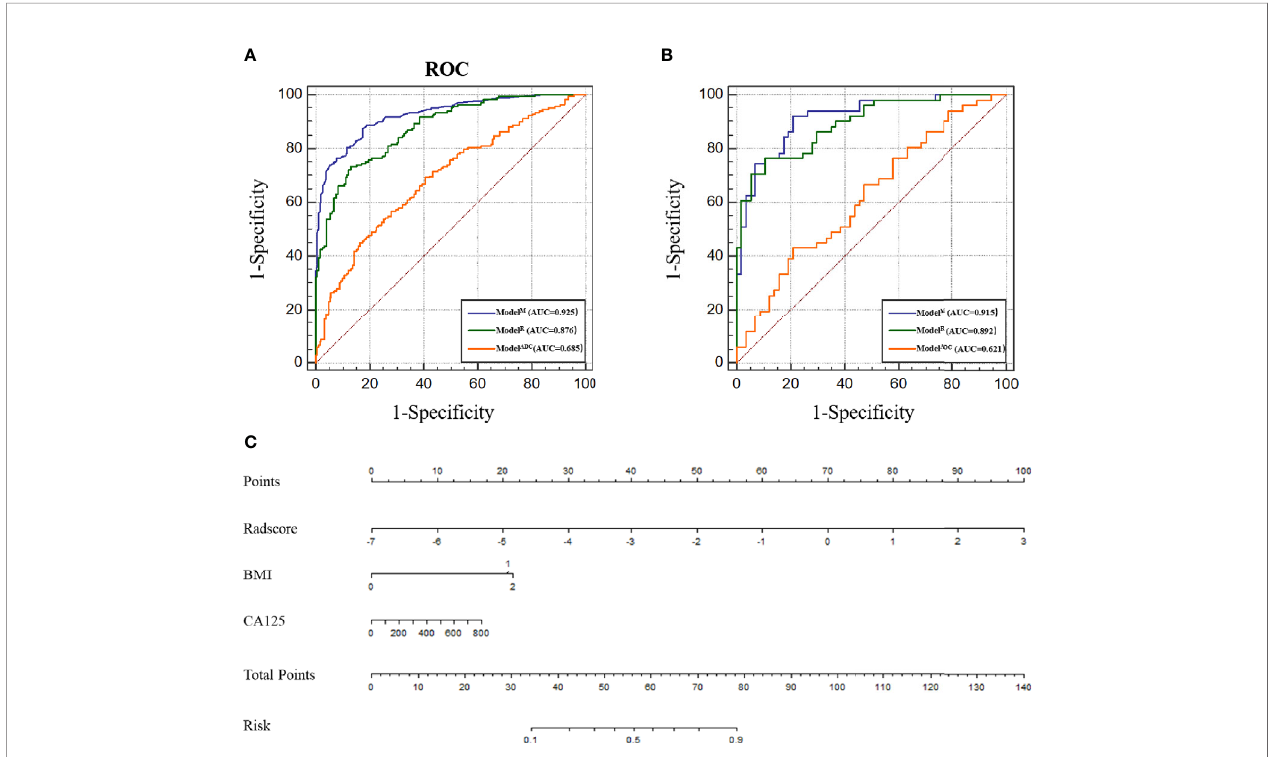
FIGURE 3 | (A) Receiver operating characteristic (ROC) of different models in the training cohort. (B) ROC of different models in the test cohort. (C) Nomogram for predicting risk classi fi cation of EC. The nomogram was built in the training cohort with the Radscore, BMI and CA125. The probability of each predictor can be converted into scores according to the fi rst scale points at the top of the nomogram. After adding up the scores of these predictors in total points, the corresponding prediction probability at the bottom of the nomogram is the malignancy of the tumor. Table 2 ) for the training and test cohorts, respectively ( Figure 3 ).